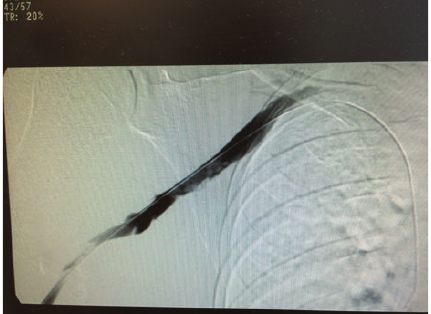
Figure 5: Successful venolysis.